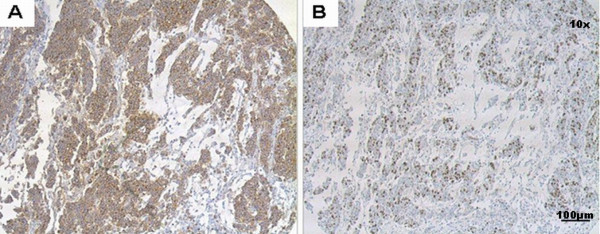
Example of A: EpCAM expression with corresponding B: Ki67 expression.